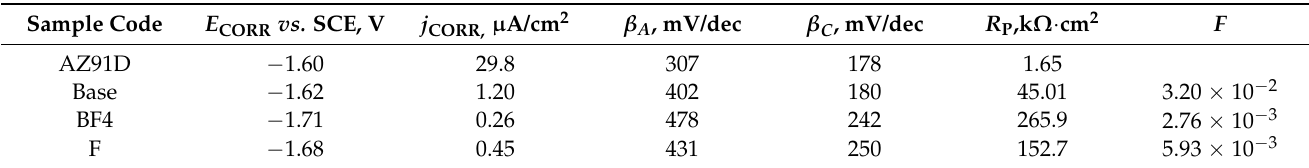
Figure 8. Potentiodynamic polarization curves of the uncoated AZ91D Mg alloy and the samples with coatings formed in the PEO process. Table 7. Potentiodynamic polarization parameters of the uncoated AZ91D Mg alloy and the samples with coatings formed in the PEO process.